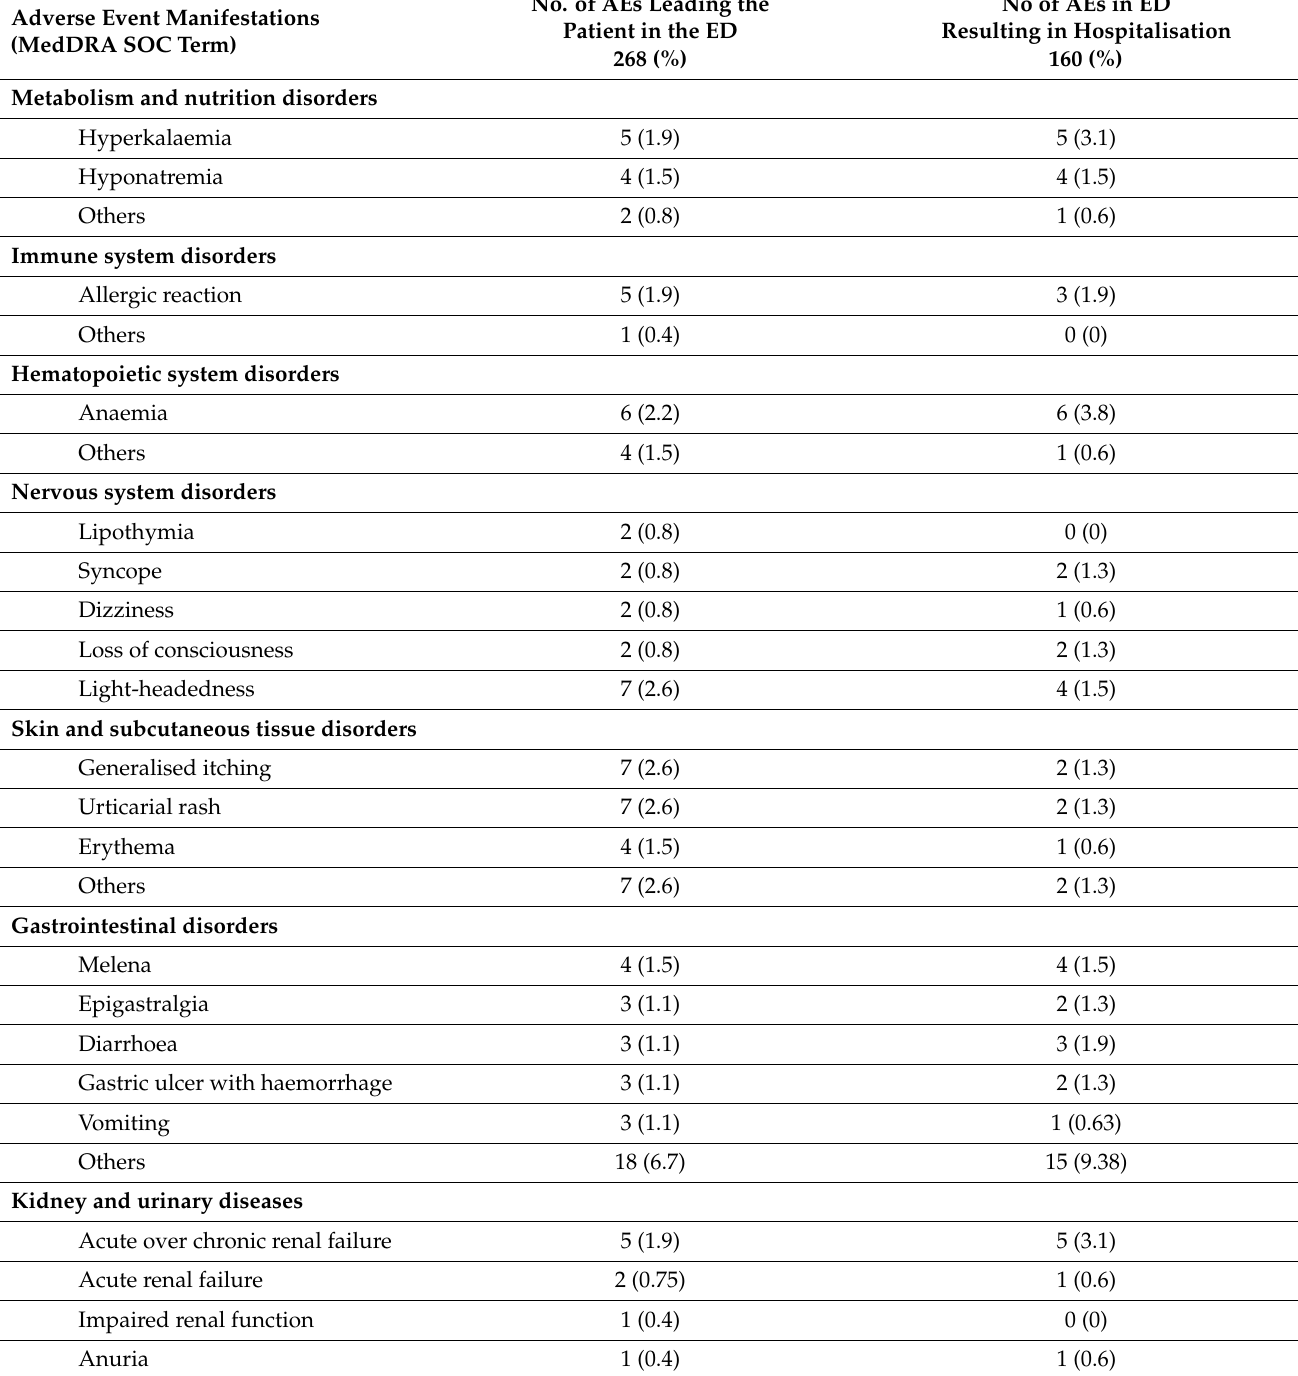
Table 4. Manifestations of adverse